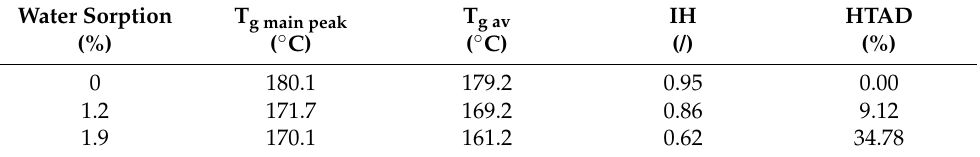
Table 3. Computational analysis results for the filled system at different water amount percentages. Water